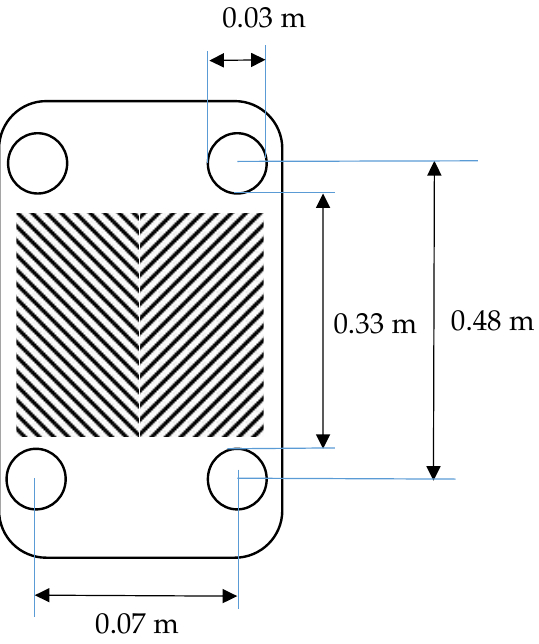
Figure 4. Characteristics of the corrugated PHE.